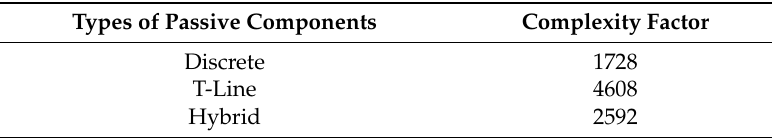
Table 2. Complexity factor for conventional DPA designs.